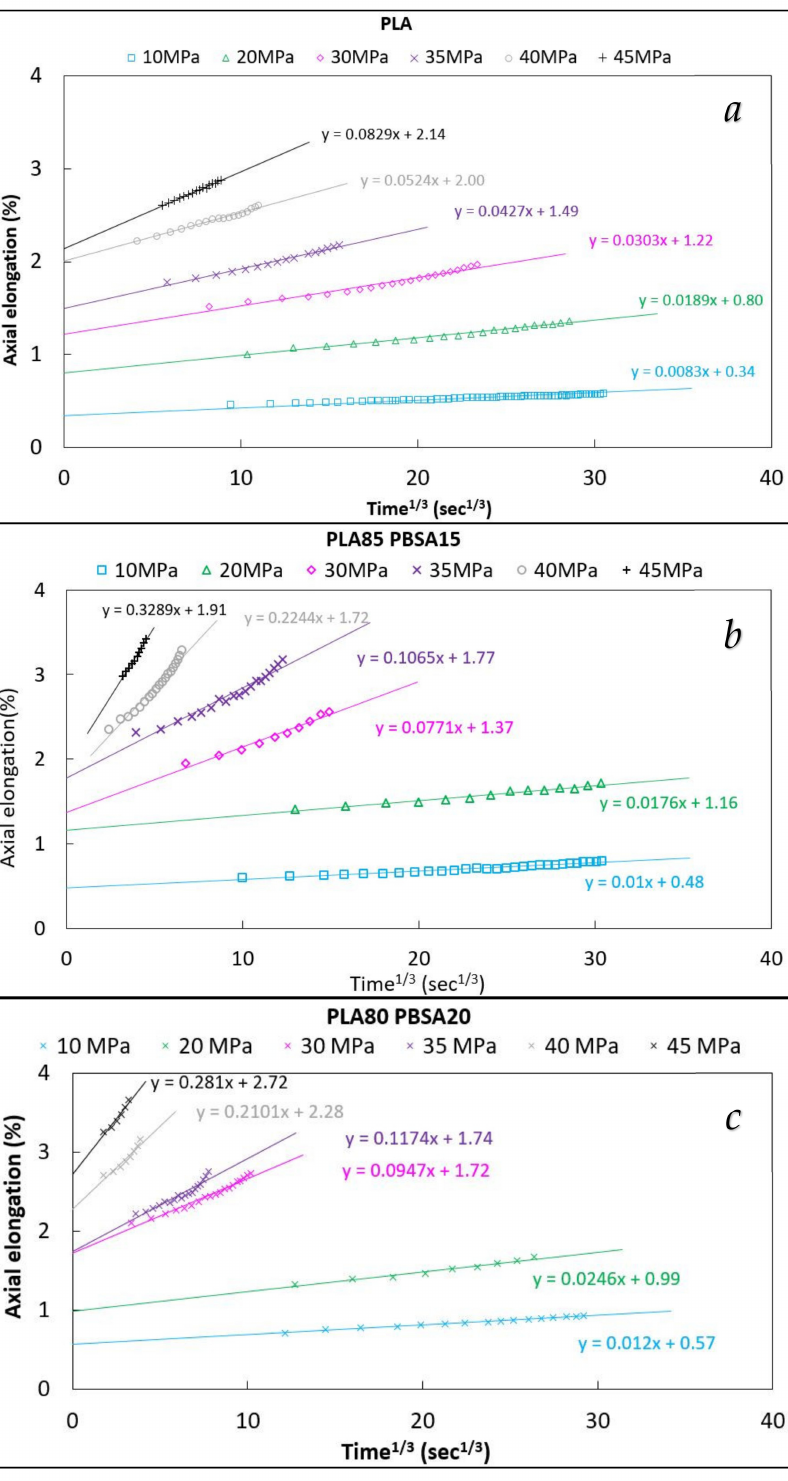
Figure 4. Andrade equation fittings (axial elongation vs. cubic root time) of pure PLA ( a ), 85-15 ( b ), and 80-20 ( c